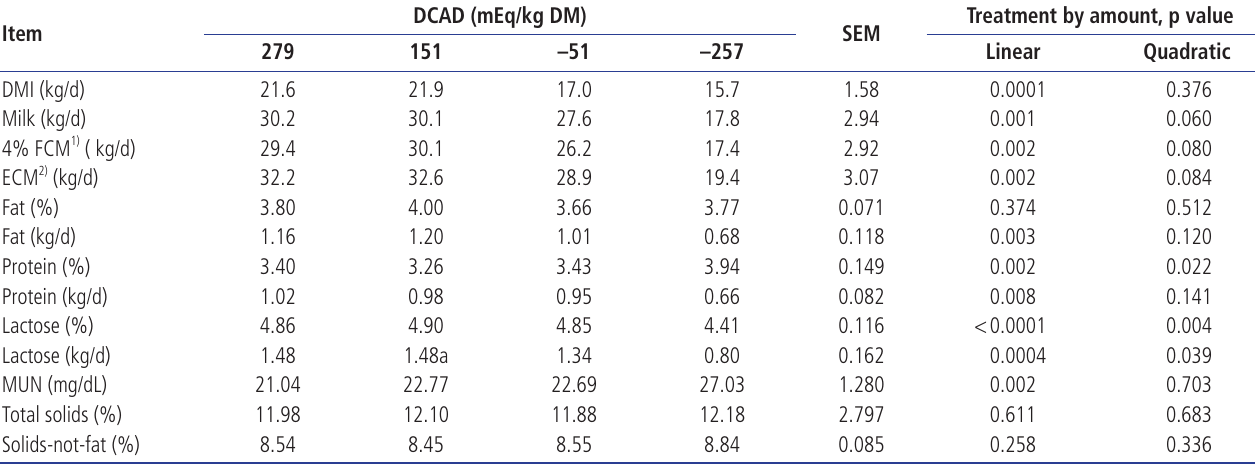
Table 3. Effects of low DCAD on dry matter intake and performance of lactating dairy cows Item